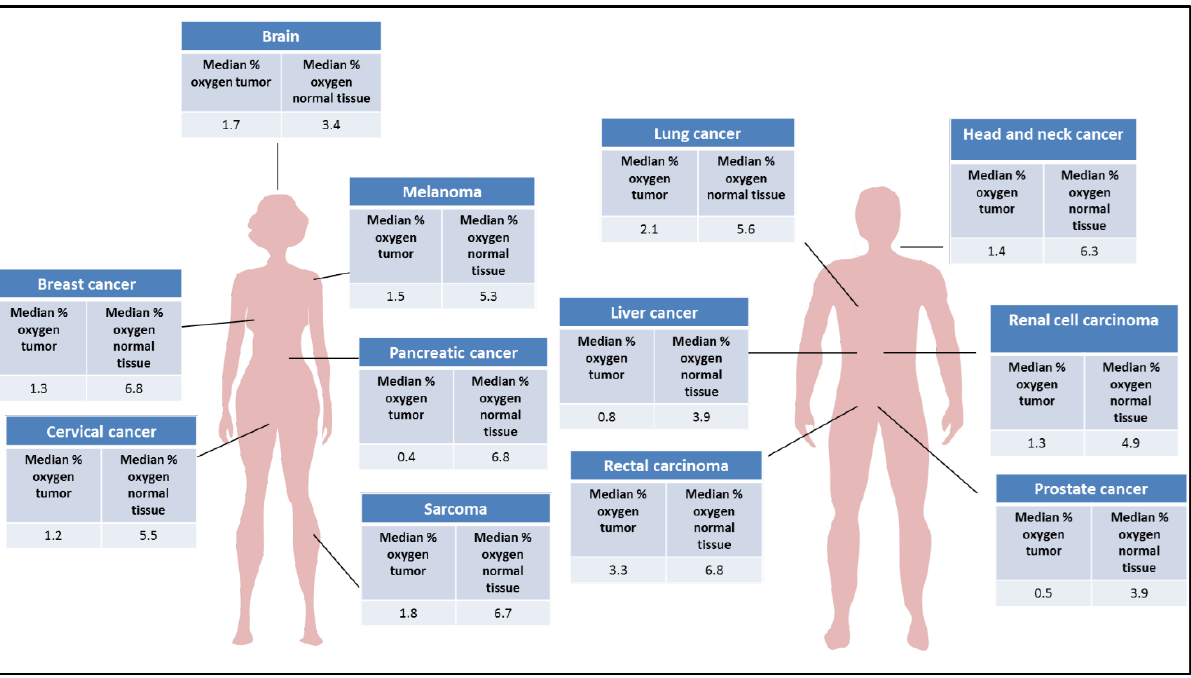
Figure 1. Median percentage oxygen in human tumors and related normal tissues. Tumor structure was described by Thomlinson and Gray in human lung cancer, who proposed the presence of an oxygen gradient which leads to a necrotic area where